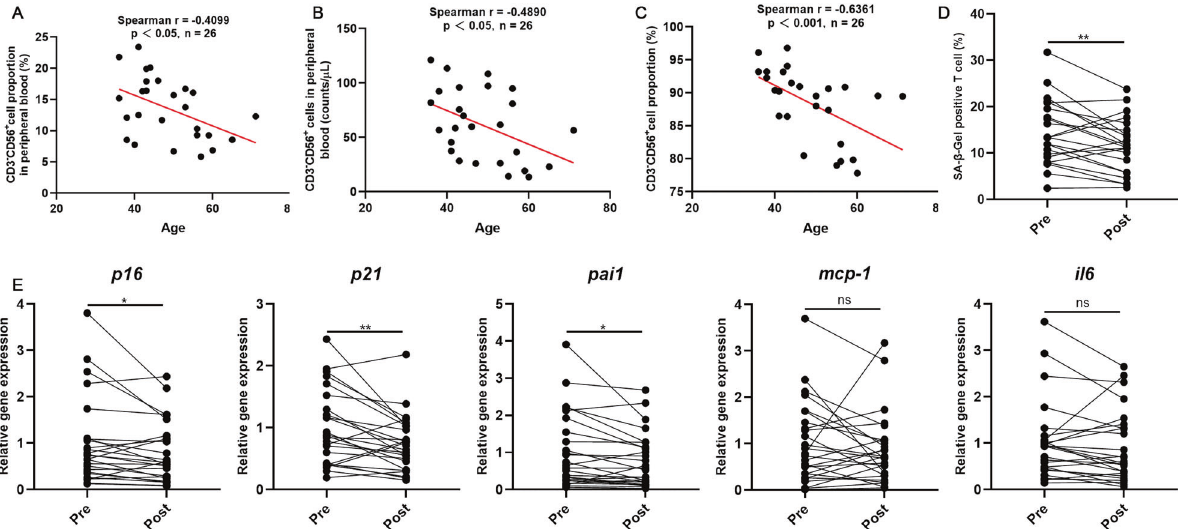
Fig. 1 Adoptive infusion of NK cells reduces senescence in peripheral blood T cells. A Correlation analyses between NK cell proportion and age ( n = 26). B Correlation analyses between NK cell numbers and age ( n = 26). C Correlation analyses between purity of the NK cell product reinfused into each individual and age ( n = 26). The spearman correlation analysis was used in all cases. The correlation was signi fi cant at 0.05 (two-sided). D CD3 + T cells were separated and SA- β -gal staining was performed pre- and post-infusion of NK cells ( n = 26). E Expression of senescence (P16 Ink4a and P21) (n = 25) and SASP markers (IL-6, monocyte chemoattractant protein-1 [MCP-1], plasminogen activator 1 [Pai1]) ( n = 26) in CD3 + T cells were analysed by qRT-PCR. Differences were assessed by the two-tailed paired Student ’ s t -test. ns P > 0.05, * P < 0.05, ** P < 0.01. Two parallel samples were set in each experiment and three independent experiments were performed for each